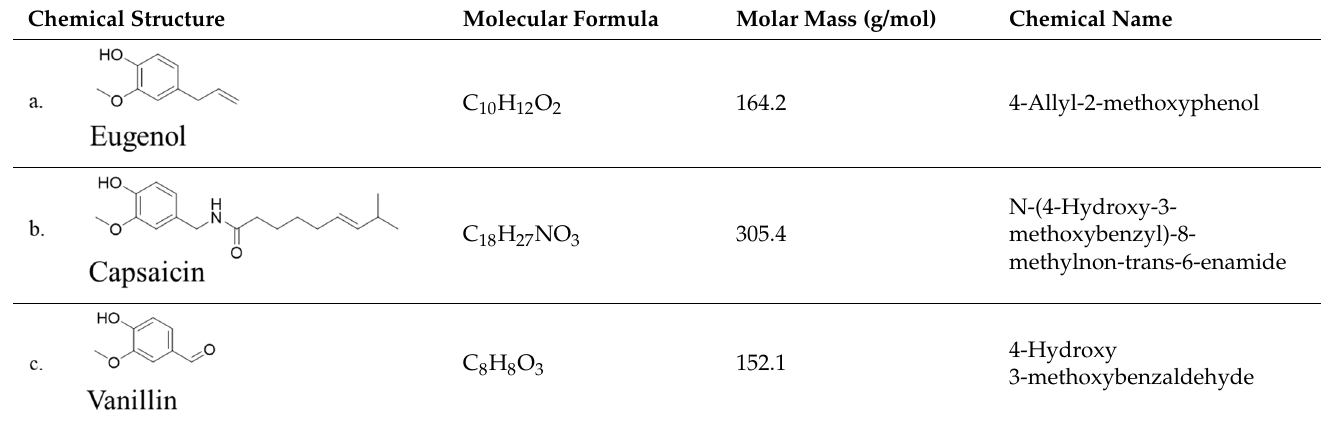
Table 1. Chemical information on eugenol, capsaicin, and vanillin.